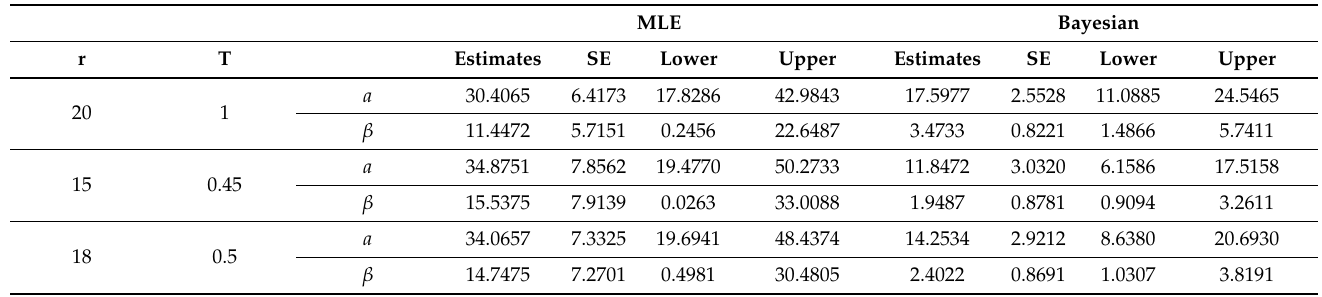
Table 13. MLE and Bayesian estimation for TCP-ITL based on hybrid censored samples with different cases: Data set